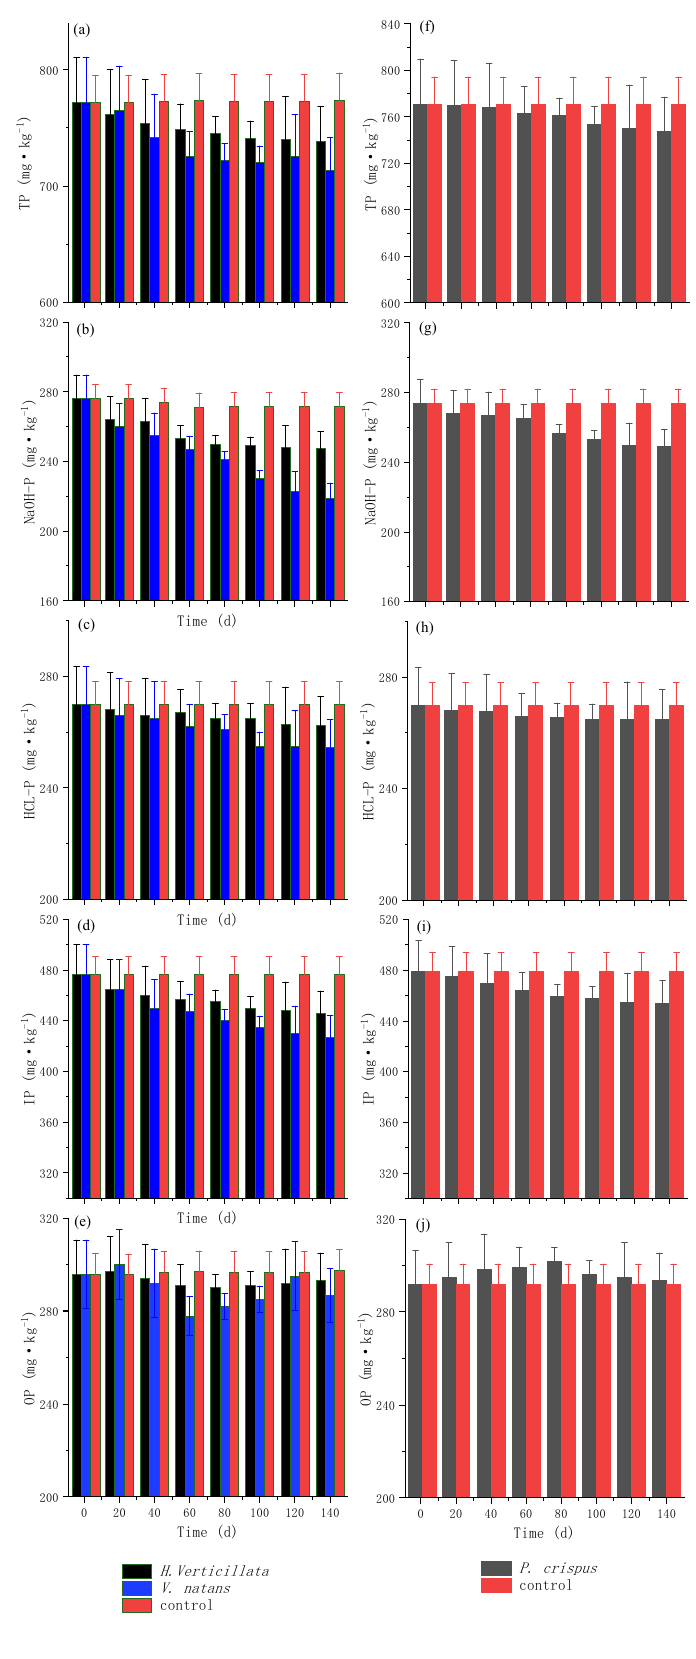
Fig. 4 P concentration of sedi- ment over the study period. The results are the mean ±